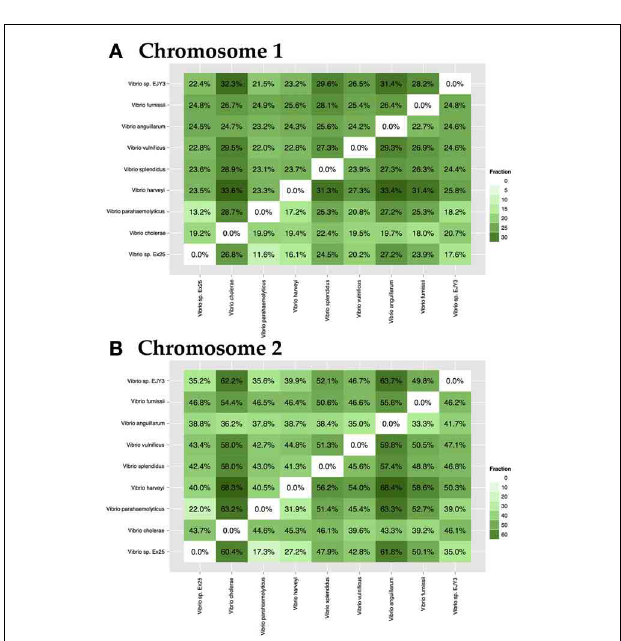
FIGURE 6 | Pairwise interspecies-specific genome comparison for chromosome 1 (A) and chromosome 2 (B). Analysis included a single representation of 7 known and 2 unknown species. The resulting percentage shows the ratio between the amount of species-specific families and the size of the total proteome. On average, each species contained between 18 and 33% specific protein families. Color intensity indicates the level of specificity.